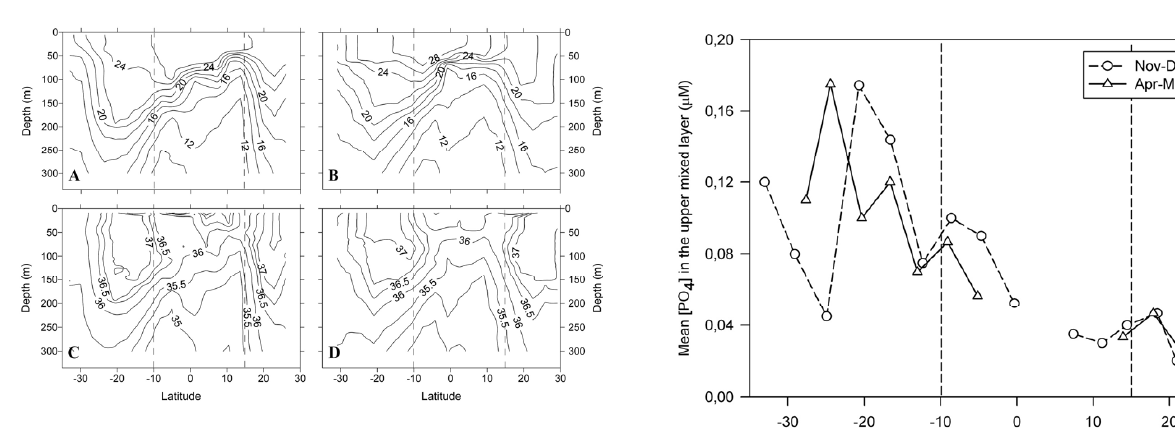
Fig. 2. Latitudinal and vertical distribution of temperature (a, b) and salinity (c, d) . Left-hand and right-hand plots correspond to the 2007 and 2008 cruises, respectively. Dashed lines define the limits of the three major regions identified by the depth of 16 ◦ C isotherm: North gyre, equatorial upwelling and South gyre.